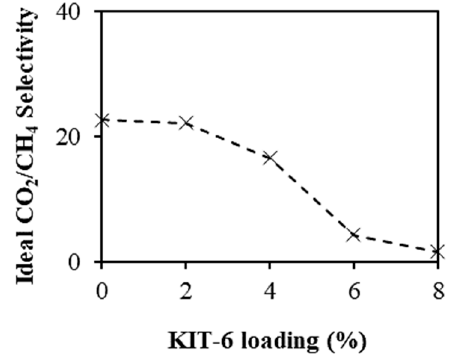
Figure 8. Effect of KIT-6 loading on CO 2 /CH selectivity at 5 bar pressure difference and 25 °C.